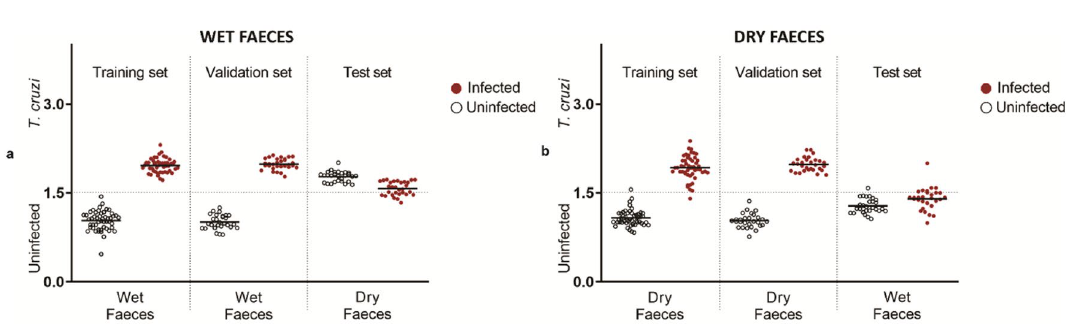
Figure 4. Regression coefficients. Regression coefficients using 6 and 5 factors for ( a ) wet and ( b) dry excreta, respectively, in the PLS model based on the NIR spectra in the 1600–1800-nm region for differentiating T. cruzi - infected from uninfected excreta.